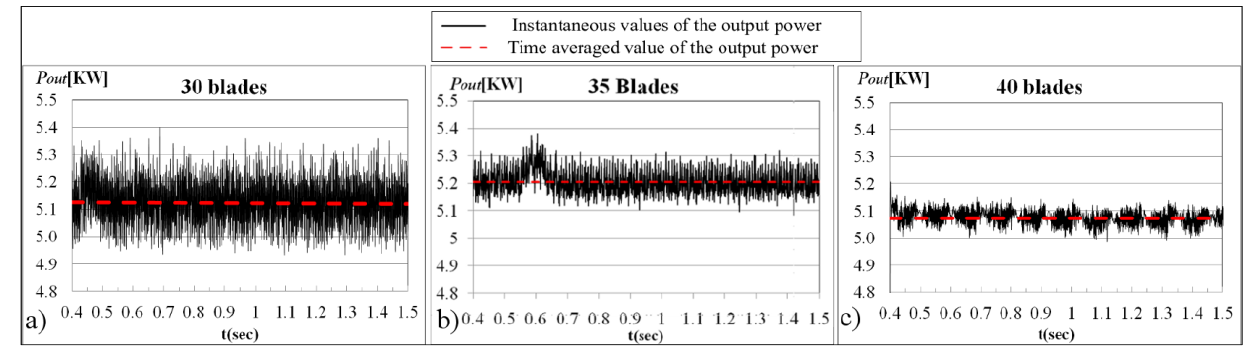
for the impeller with a different number of out . out